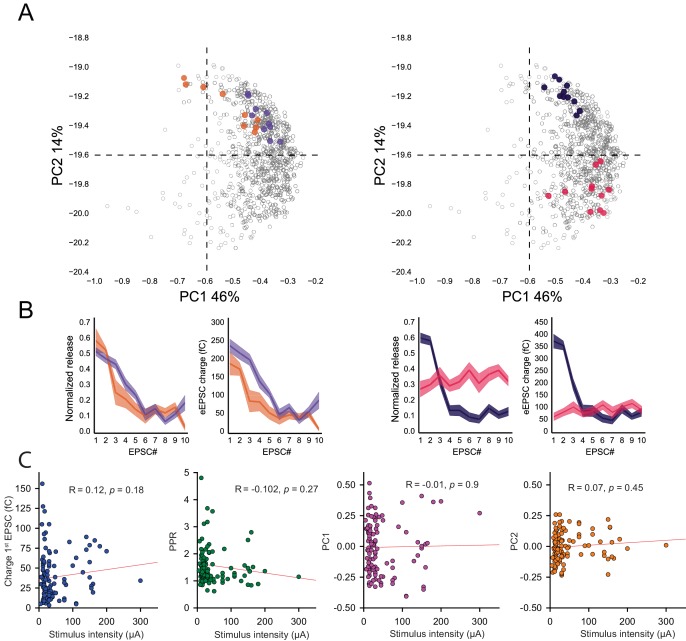
Robustness of intrinsic STP evoked by 100 Hz train at unitary GC-MLI synapses.(A) Functional mapping of synaptic responses recorded during 100 Hz trains in 99 neurons (See Materials and methods). PCA transformation are computed independently for each train (n > 1000) based on the charge value of each EPSC in the train. Consecutive recordings from the same synaptic terminals are represented with the same color code (orange, purples blue or pink points). Note that these recordings are located in a very specific position inside the cloud of points indicating that the profile of STP is conserved during successive stimulation at 100 Hz of the same synaptic input. (B) Normalized EPSC charges plotted against the stimulus number for responses highlighted in A (same color code). Left panel, synaptic responses from synapses with the same behavior during 100 Hz train are clustered nearby inside the PCA transform. Right panel, synaptic responses from synapses with distinct behaviors during 100 Hz trains are positioned at distant positions in the PCA transform. (C) STP profile was not skewed by changes in PF excitability in minimal stimulation experiments. Potentially, high current values can recruit additional PFs during trains and low current values can be associated with failures of PF excitation. These non-synaptic phenomena can induce unexpected changes in the profile of STP. However, neither charges of EPSC at the first stimuli (blue points), PPR (green points), PC1 (purple point) or PC2 (orange points) could be correlated with stimulus intensities. The lack of valid relationships between these parameters and current intensity indicated that in the vast majority of experiments, STP profile was shaped by synaptic mechanisms rather than change in PF excitability.